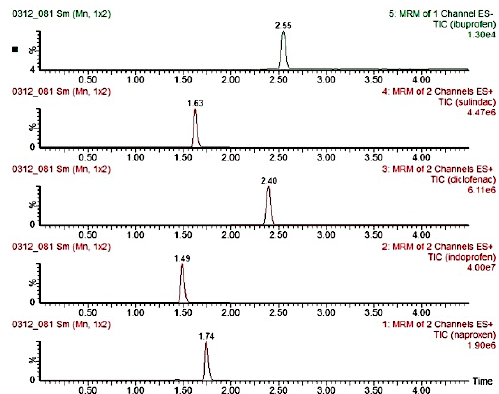
Figure 5. UPLC–MS / MS chromatograms showing the detection of five targeted NSAIDs extracted from Figure 5. UPLC–MS/MS chromatograms showing the detection of five targeted NSAIDs extracted e ffl uent water samples spiked at 10 ng L − 1 from effluent water samples spiked at 10 ng L − 1 .